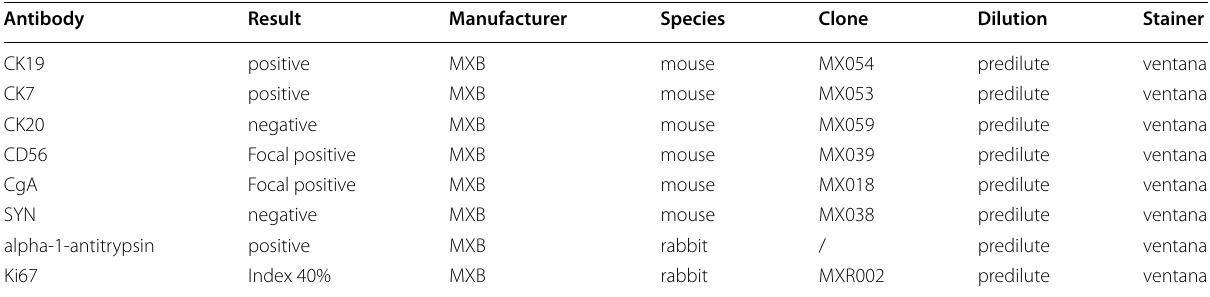
Table 1 Performed immunohistochemical stains, with interpretation and technical